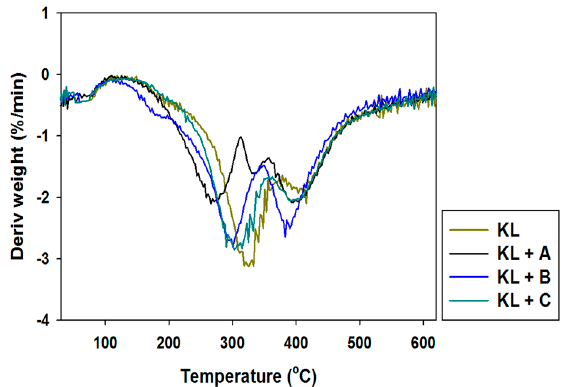
Figure 6. Differential thermogravimetry (DTG) curves of kraft lignin and activated lignins by selected ionic liquids.